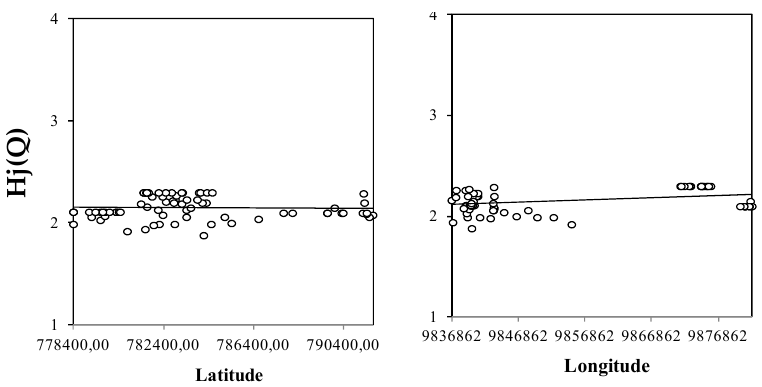
Figure A4. Preliminary drift analysis for the spatial Figure B4. Preliminary drift analysis for the spatial domain.